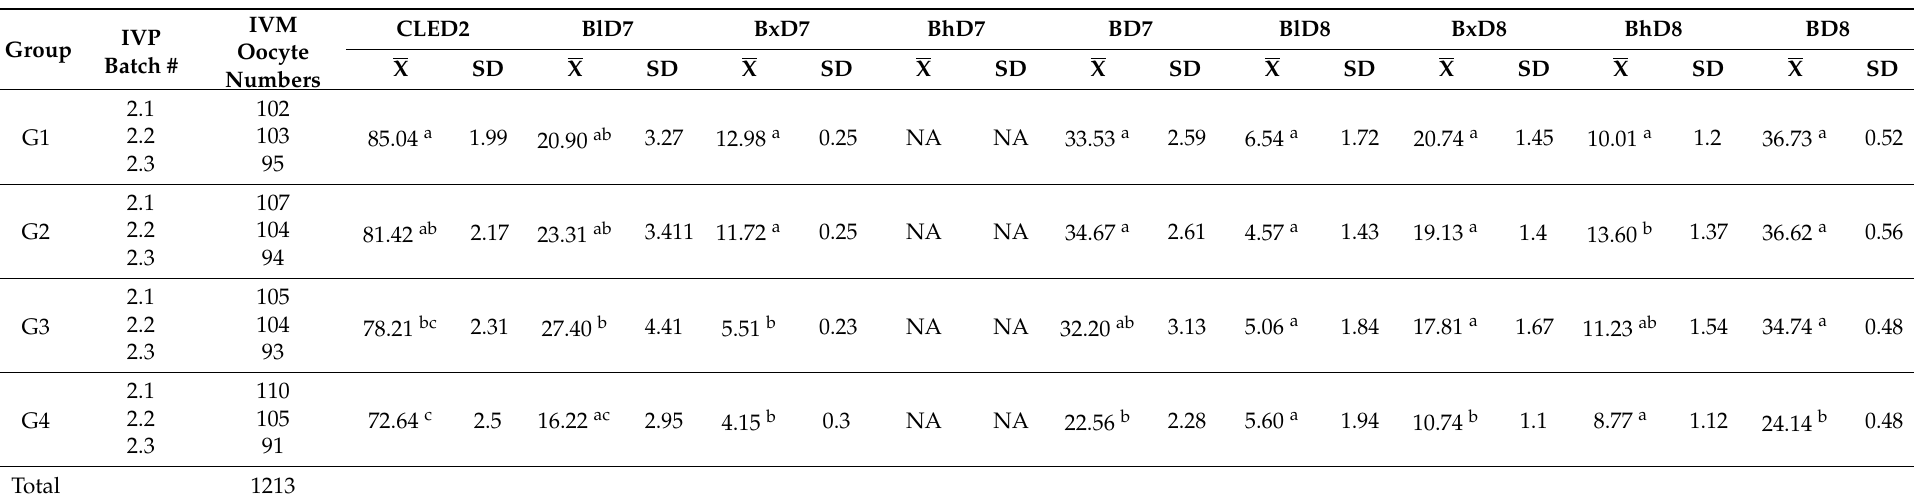
Table 2. Numbers (n) and percentage ratios for the percentages of embryonic development parameters (CLED2; BlD7; BxD7, BhD7, BD7, BlD8, BxD8, BhD8, and BD8). All percentage ratios were calculated using the IVM oocyte number for each IVP replicate. CLED2 was evaluated 36 to 48 h after IVF and 7 (D7) and 8 days (D8) after cultivating IVM when comparing the 4 treatment groups (G1, G2, G3, and G4) and 3 IVP batches (1, 2, and 3) used in Experiment 2 (SOF medium supplementation with test items at different concentrations for each treatment